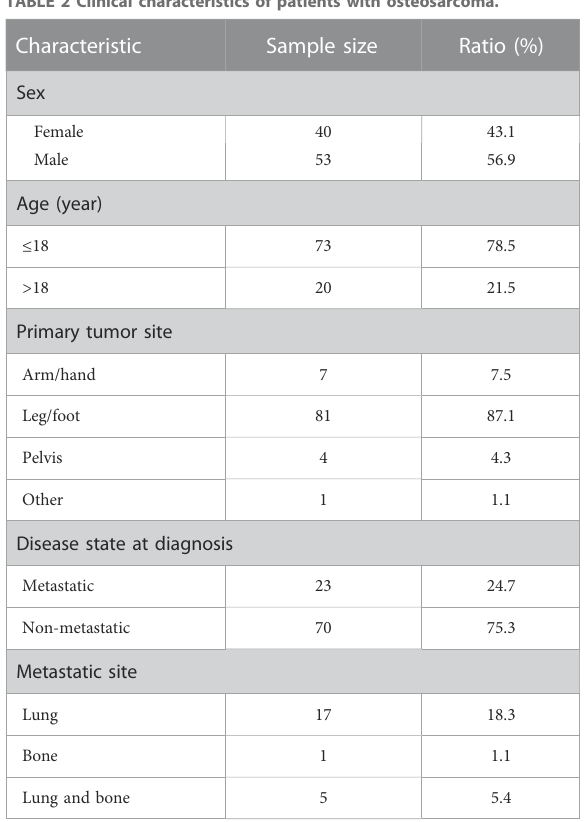
TABLE 2 Clinical characteristics of patients with